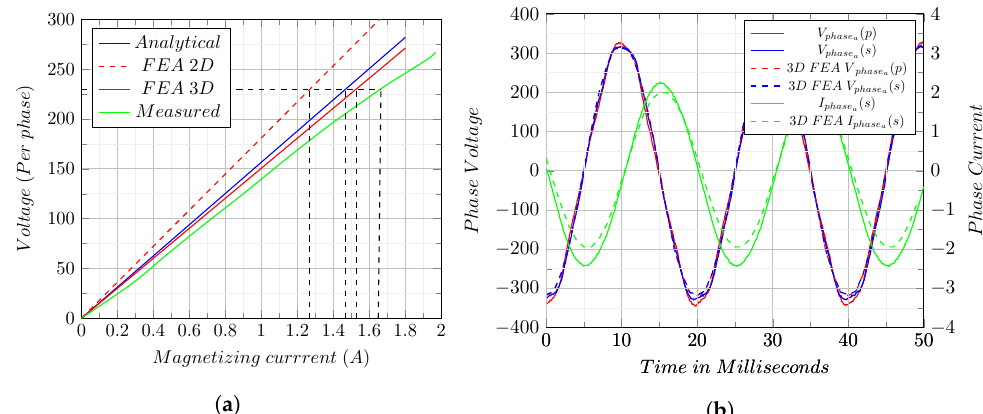
Figure 11. ( a ) Per-phase open circuit magnetization curve and ( b ) measured and simulated phase voltage and current waveforms for phase A at no load.